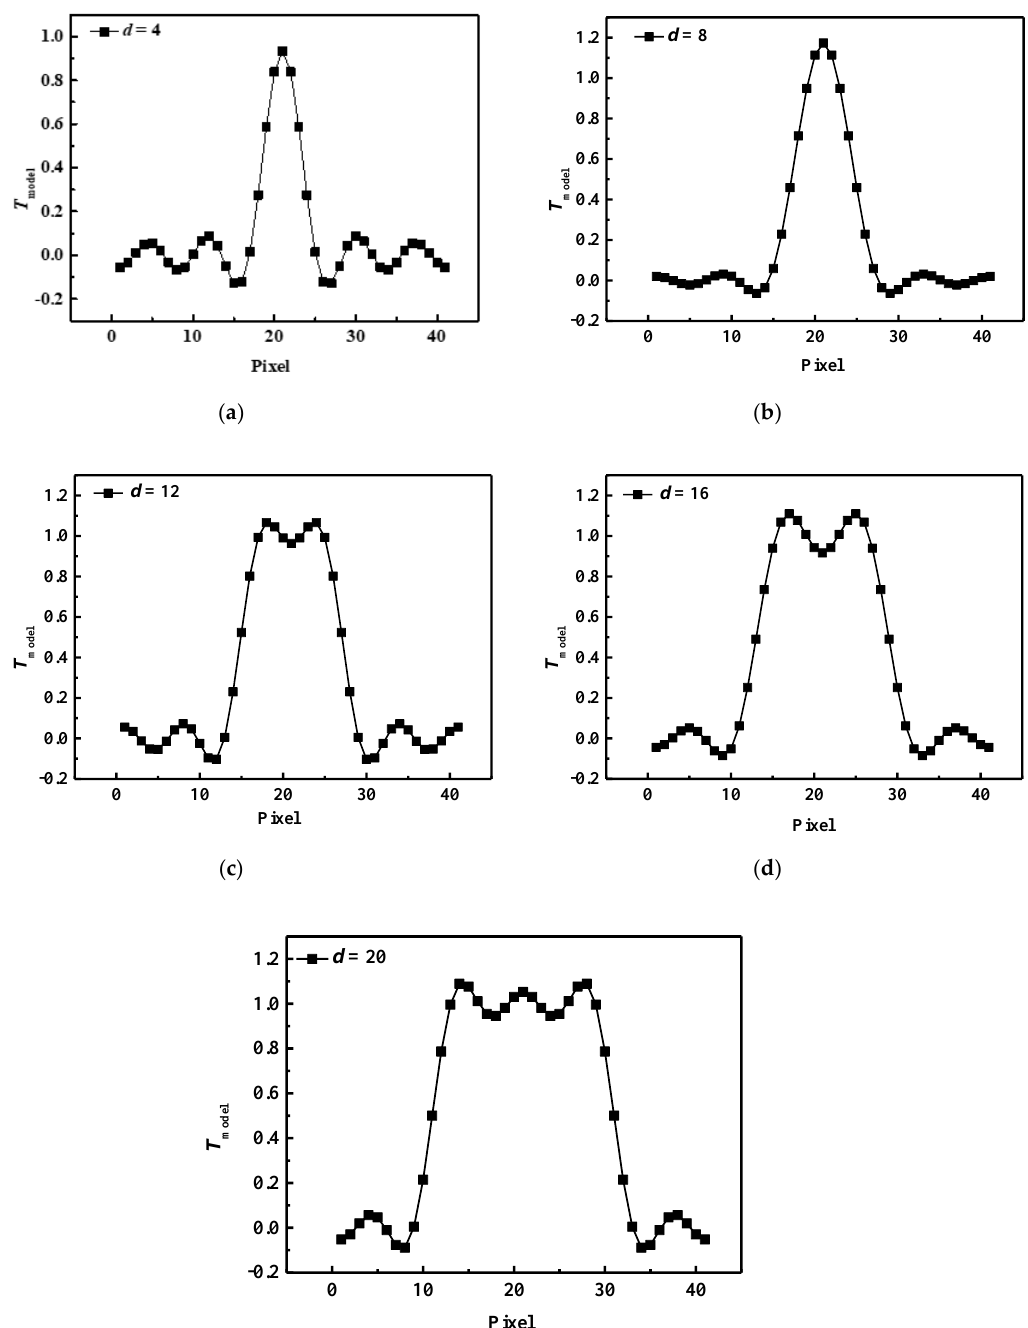
Figure 11. The discrete form of the Fourier series expansion of Equation (8) with different value of d : ( a ) d = 4 pixel; ( b ) d = 8 pixel; ( c ) d = 12 pixel; ( d ) d = 16 pixel and ( e ) d = 20 pixel.